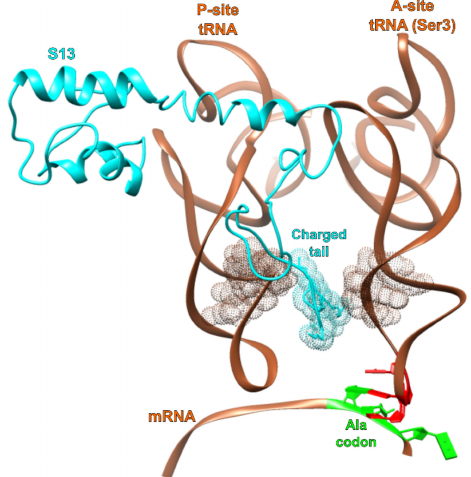
Figure 6. Interaction of S13 with tRNA A and P site tRNAs. The C-terminal region of ribosomal protein S13 (teal) inserts between the A- and P-site tRNA (copper) anticodon stems. This reduces the intervening space and may produce entropic pressure against adopting the − 1 frameshifting